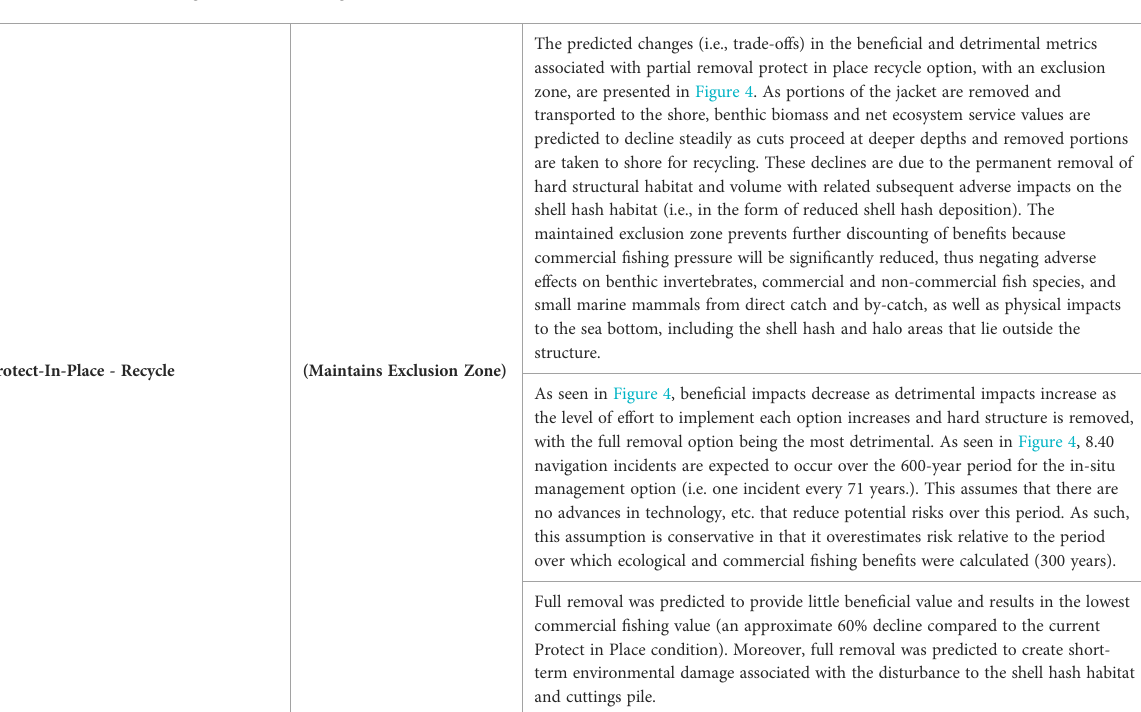
TABLE 3 North Sea Case Study Results